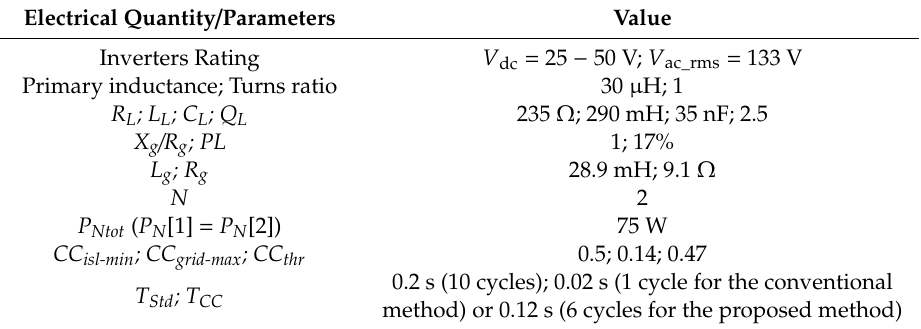
Table 2. System parameters and anti-islanding algorithm parameters of the experimental